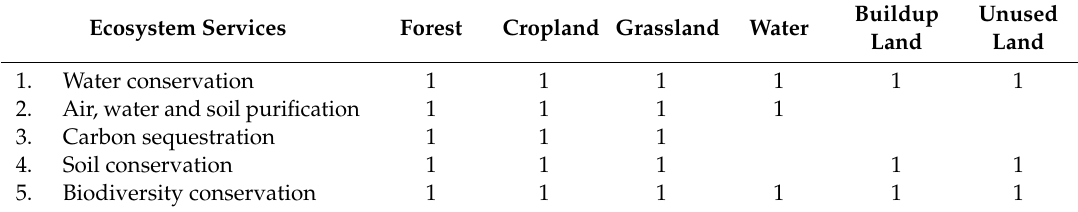
Table 2. Land types and considered ecosystem services (ESs) in this study.